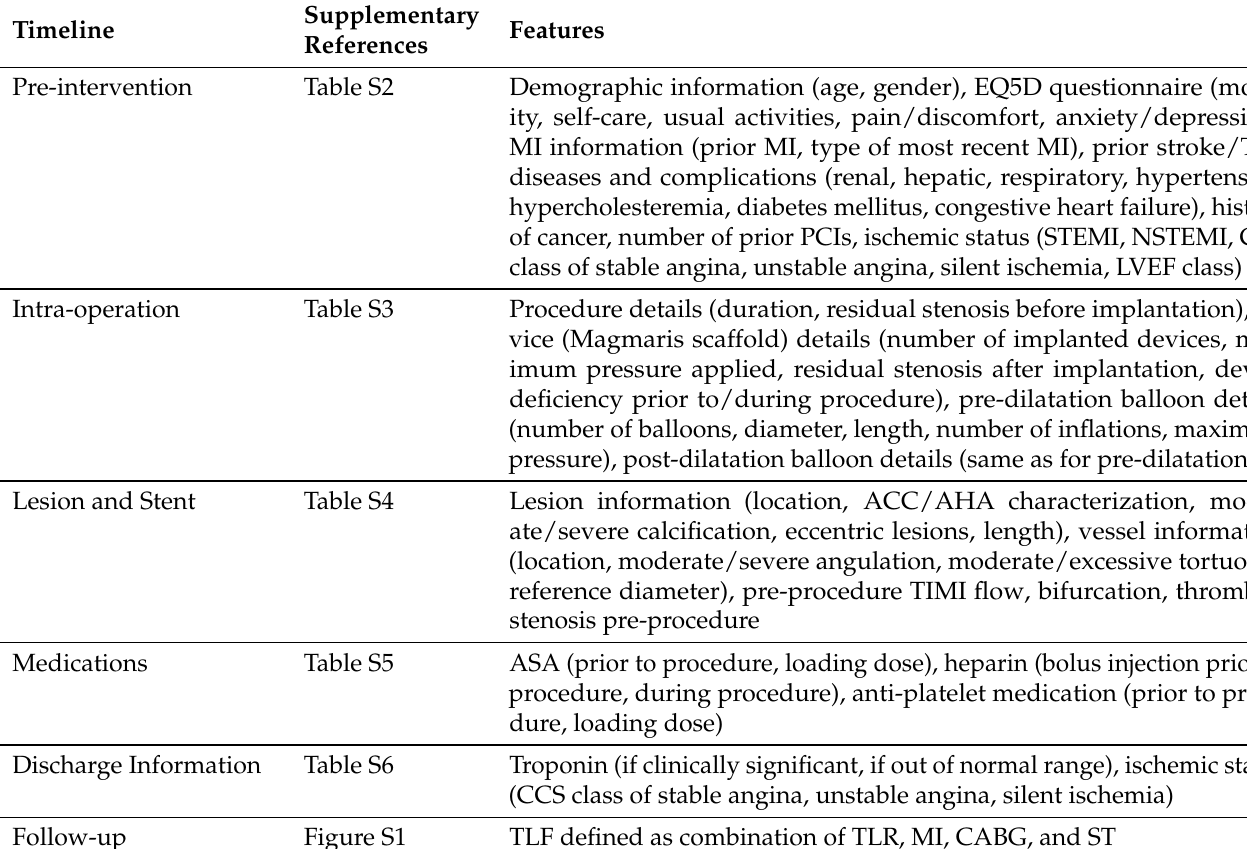
Table 2. Summary of 86 features used in our study, grouped by the timeline of treatment for each individual patient.